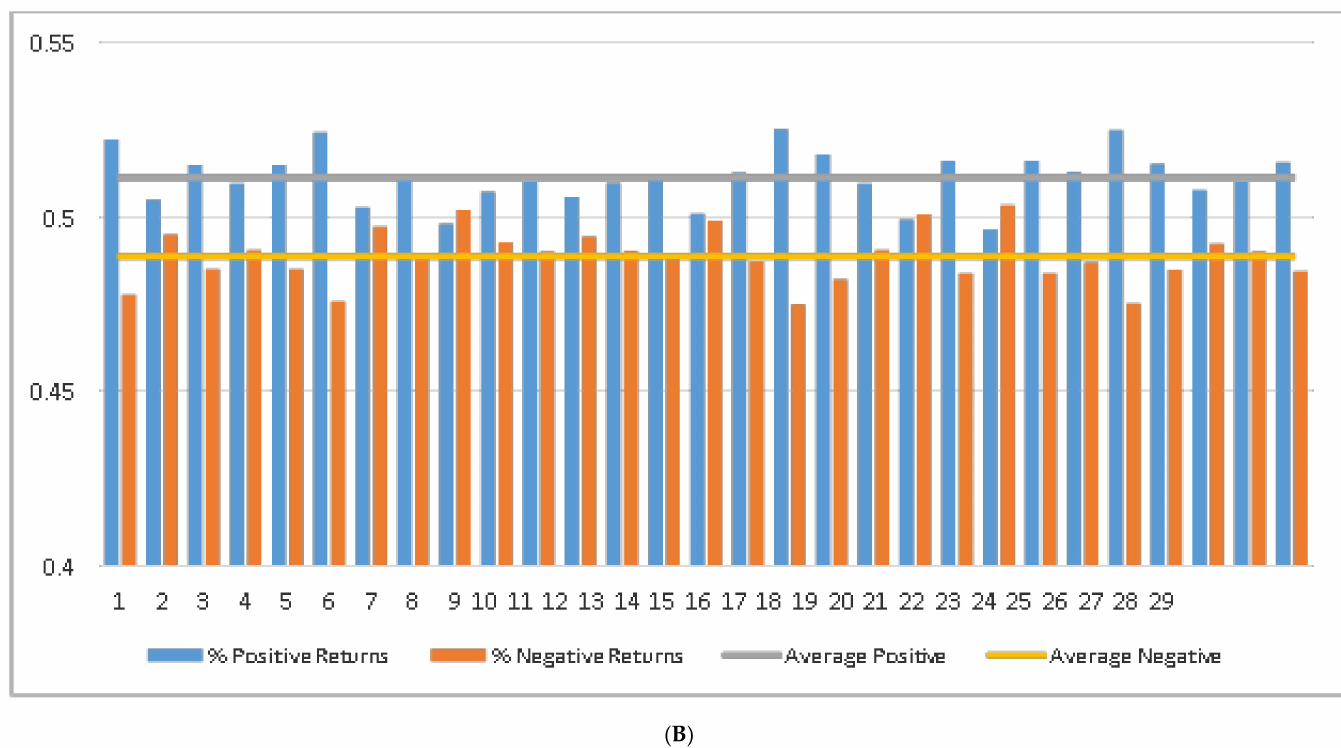
Figure 3. ( A ) Percentage of Positive and Negative Returns in Each of the 21 DSE Stocks. Average success rate (positive returns) equals 46.33% for DSE stocks; ( B ) Percentage of Positive and Negative Returns in Each of the 29 Dow Jones Stocks. Average success rate (positive returns) equals 51.13% for Dow Jones